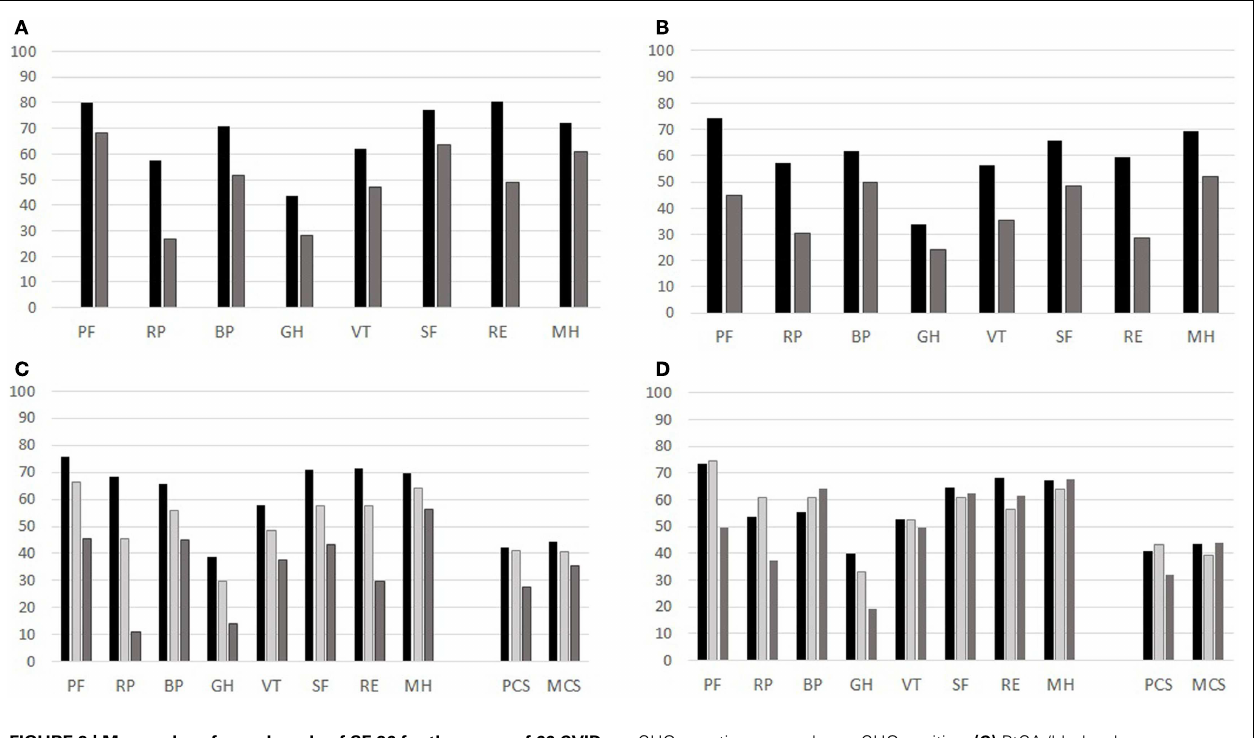
FIGURE 3 | Mean values for each scale of SF-36 for the group of 66 CVID patients observed at different times (T0,T1,T2), GHQ status (T0 andT2) and PtGA and PhGA assessments . (A) GHQ atT0: black column GHQ-negative; gray column: GHQ-positive. (B) GHQ atT2: black column